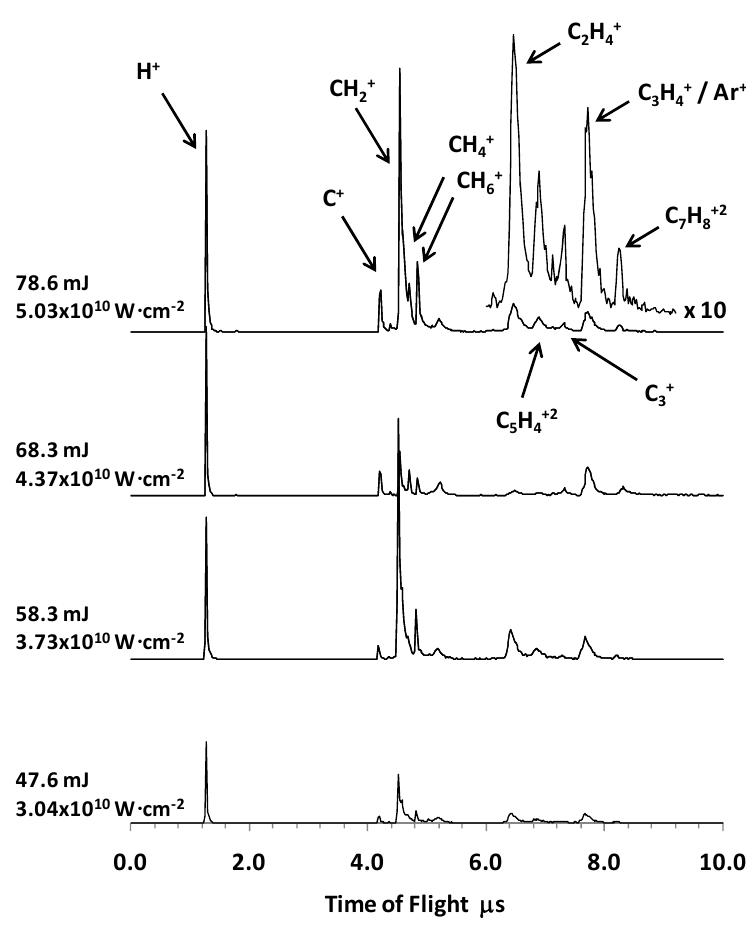
Figure 2. PD - ToF spectra at 355 nm, with carrier